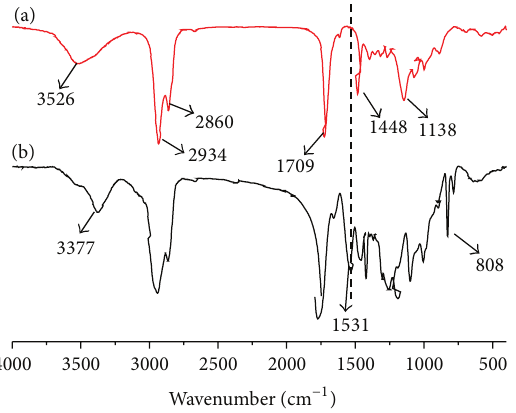
Figure 2: FT-IR spectra of CF resin (a) and UVCF resin (b).